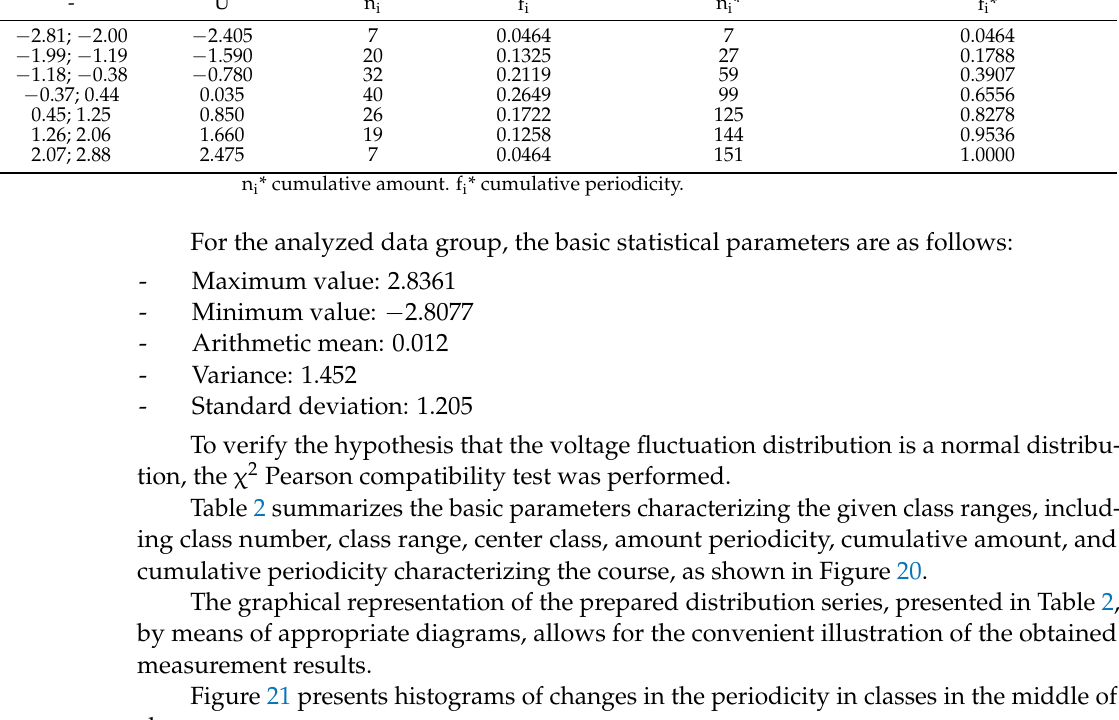
Table 2. Amount and periodicity of the resolving series and the cumulative resolving series of voltage fluctuations. Class Number Class Range Periodicity Cumulative Amount Cumulative Periodicity